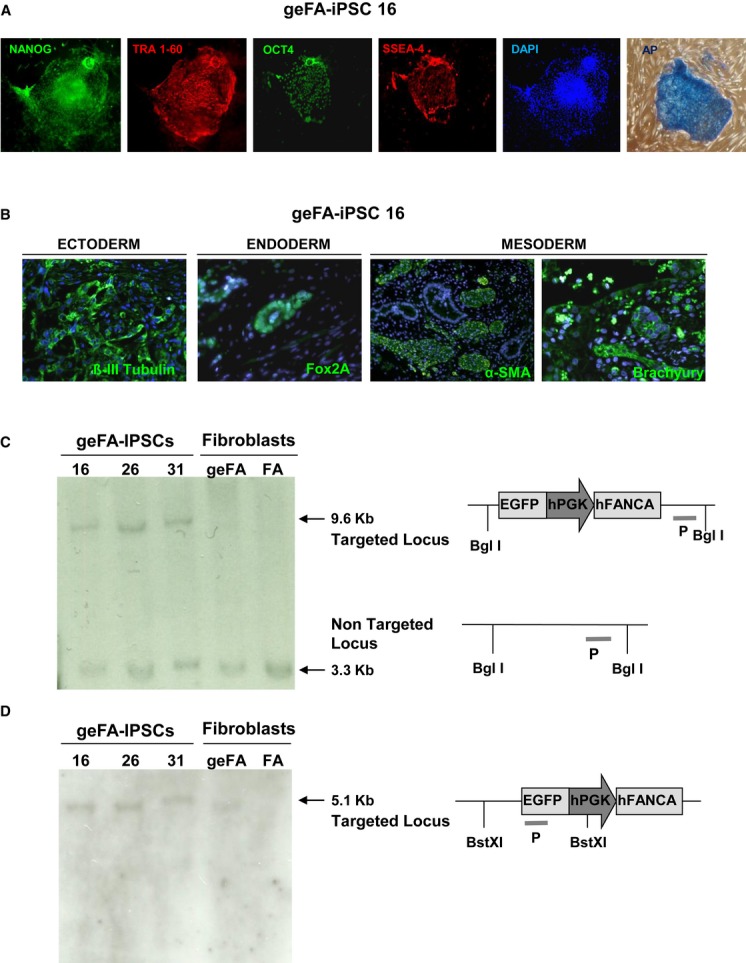
Pluripotency characterization and insertion site analyses of gene-edited FA-A iPSCsExpression of TRA1-60, SSEA-4, OCT4, and NANOG pluripotency markers by immunofluorescence staining of gene-edited FA-iPSCs (geFA-iPSCs; clone 16).Immunofluorescence analysis of ectoderm (β-II-tubulin), endoderm (Fox2A), and mesoderm (α-SMA and Brachyury) in teratomas generated from geFA-iPSCs (clone 16).Southern blot analysis of genomic DNA extracted from the indicated gene-corrected FA iPSC clones (geFA-IPSCs) and from parental fibroblasts, either unmanipulated (FA) or after gene editing (ge-FA iPSCs, clones 16, 26 and 31). Genomic DNA was digested with BglI and hybridized with a probe for PPP1R12C. The band of 9.6 kb corresponds to the targeted integration in PPP1R12C, while the 3.3 kb correspond to the untargeted allele.Southern blot analysis of samples shown in (C) digested with BstXI and hybridized with a probe (P) for EGFP. One single band of 5.1 kb is expected for specific integrations in PPP1R12C.